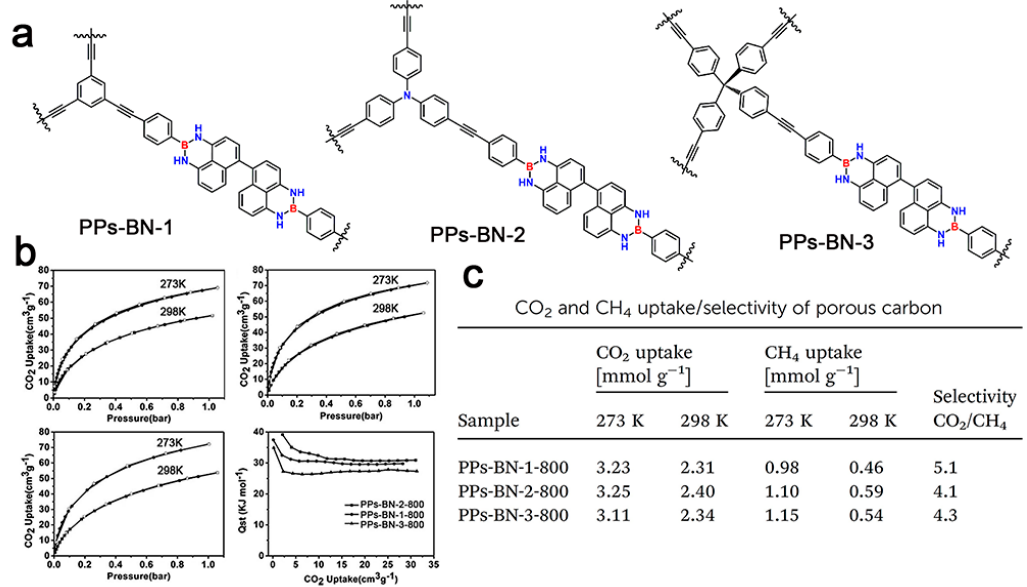
Figure 11. A structural illustration of PPs-BN-1 , PPs-BN-2 and PPs-BN-3 ( a ); CO 2 adsorption isotherms and isosteric heat of PPs-BN-1-800 , PPs-BN-2-800 and PPs-BN-3-800 at 273 K and at 298 K ( b ); CO 2 and CH 4 uptake/selectivity of porous carbon ( c ). Reprinted with permission from [85]. Copyright 2015, The Royal Society of Chemistry.